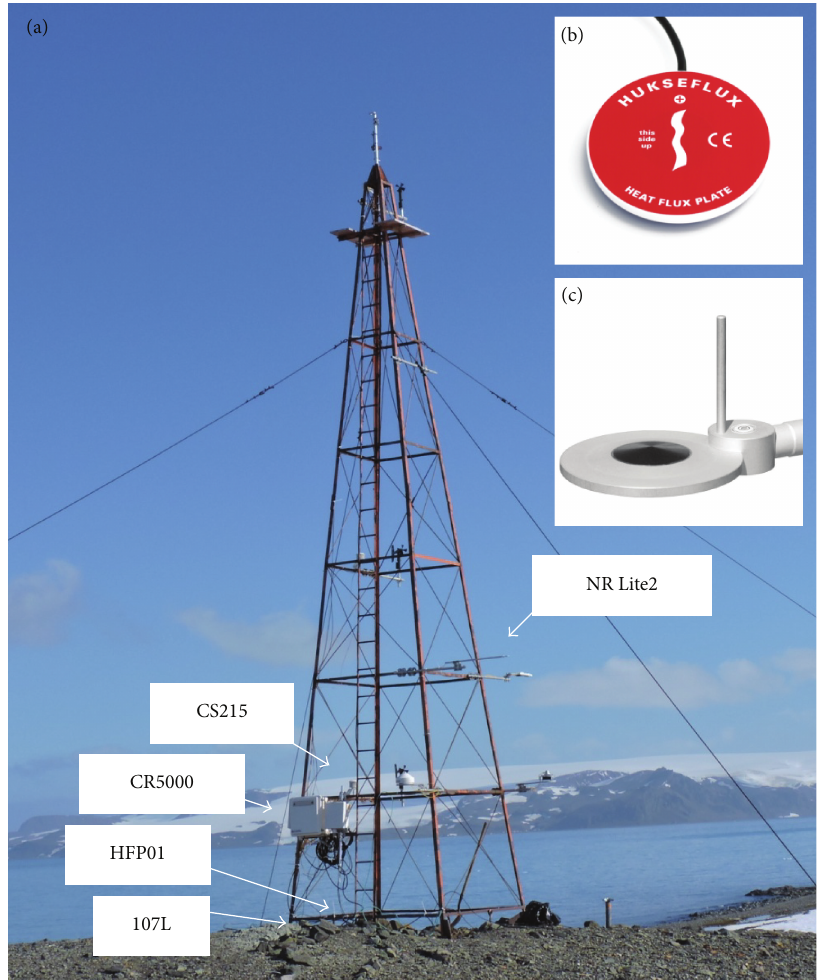
Figure 3: (a) Micrometeorological tower at the EACF, (b) soil heat flux instrument (HFP01), and (c) net radiation instrument (NR Lite2).